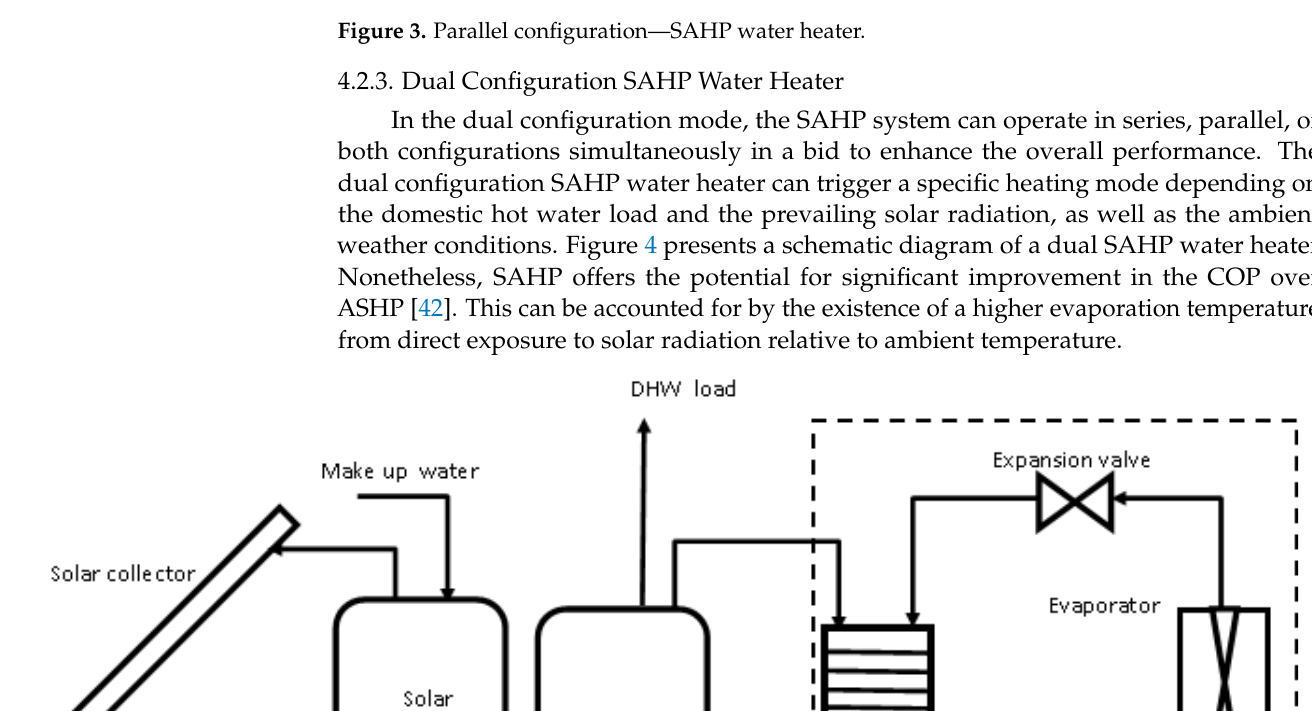
Figure 3. Parallel configuration—SAHP water heater.